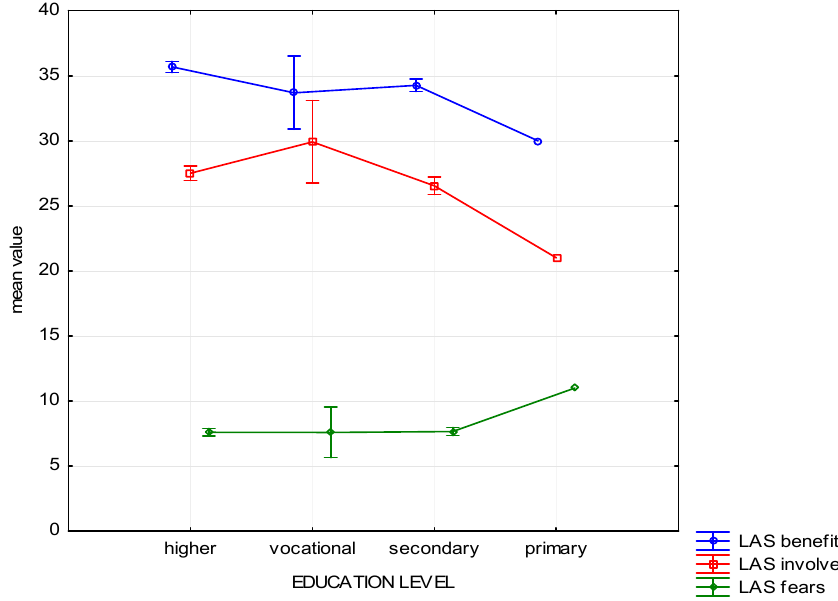
Figure 2. Attitude to the forest—mean chart for groups divided by education level.